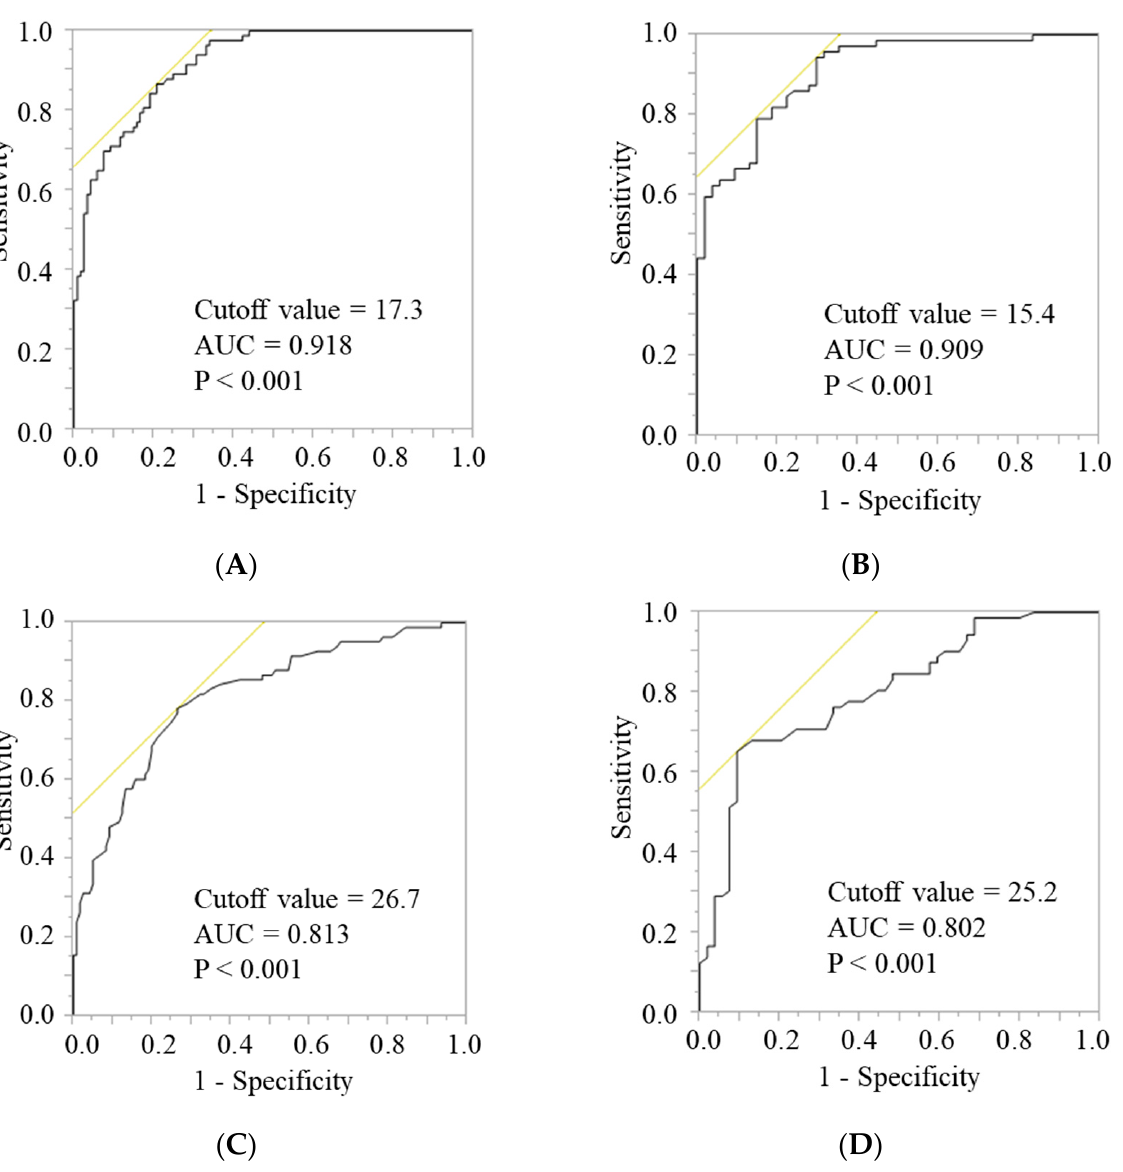
Figure 1. ROC curves to determine the cutoff values for the FFMI and AC, which discriminate the cutoff value for the SMI according to AWGS in the development group. ( A ) FFMI in men; ( B ) FFMI in women; ( C ) AC in men; ( D ) AC in women. ROC, receiver operating characteristics; FFMI, fat-free mass index; AC, arm circumference; SMI, skeletal muscle mass index; AWGS, Asian Working Group for Sarcopenia; AUC, area under the curve.